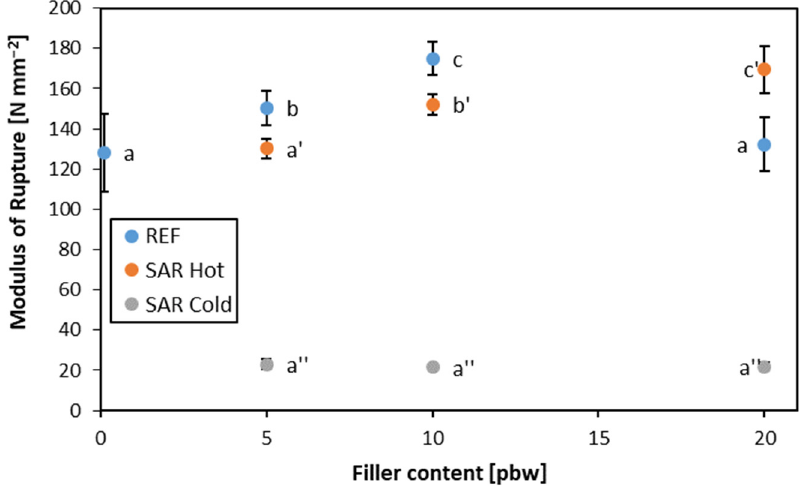
Figure 6. The modulus of rupture of the plywood samples of different filler content (the letters on the plots indicate the homogeneous groups).